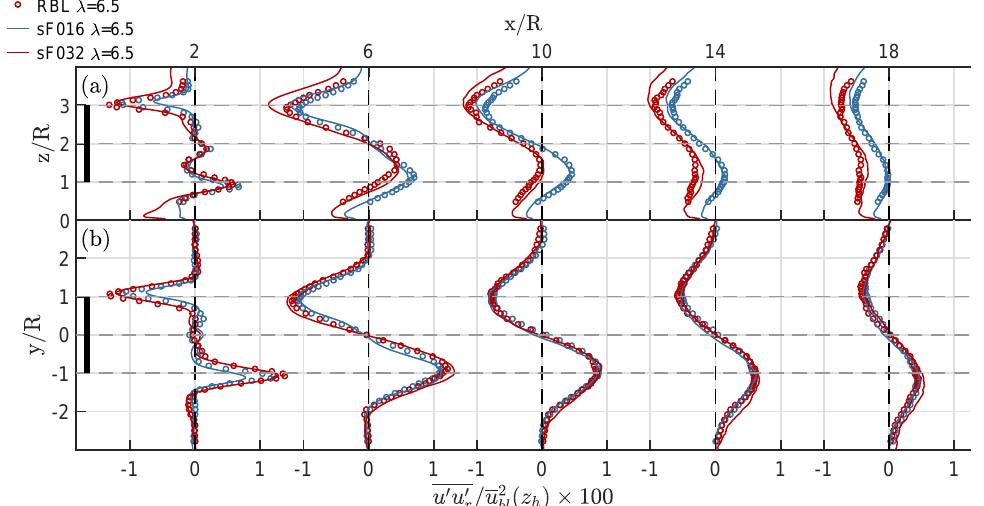
Figure 12. Profiles of the normalized Reynolds shear stress ( a ) u (cid:48) w (cid:48) / u 2 ( b ) u (cid:48) v (cid:48) / u 2 the mid − horizontal plane at axial positions x / R = 2, 6, 10, 14, 18. Symbols denote h measurements, whereas lines correspond to LES results. The legend denotes the